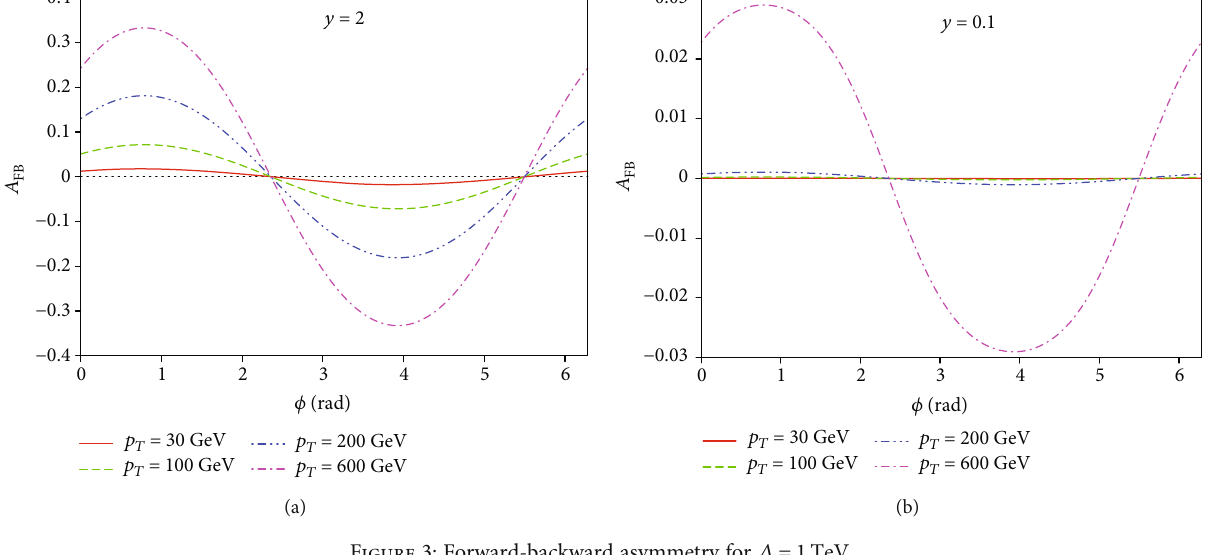
Figure 3: Forward-backward asymmetry for Λ = 1TeV .